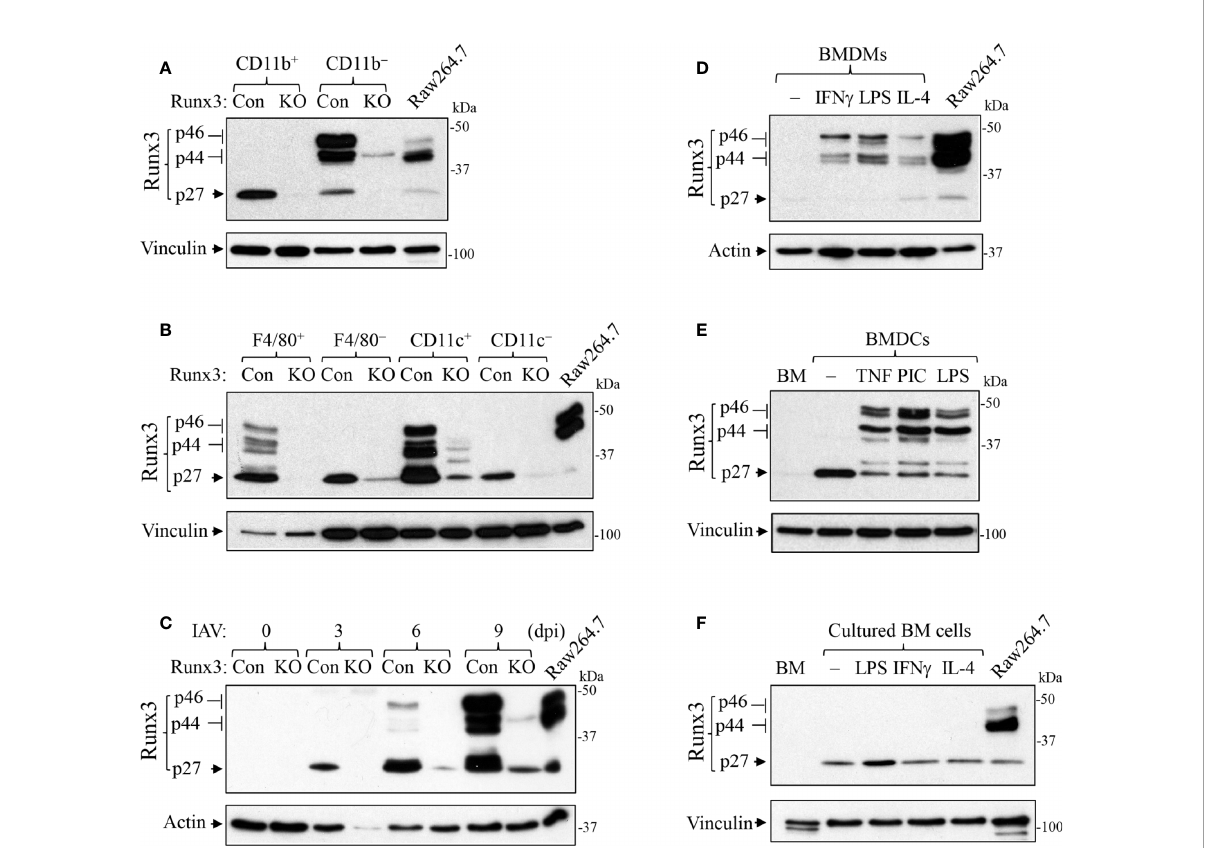
FIGURE 9 Runx3 is induced in activated macrophages and DCs. (A, B) Runx3 expression in the isolated lung innate immune cells from IAV-infected mouse lungs on day 5 pi. Equal amounts of cell lysates except that of F4/80 + cells were subjected to Western blotting with Runx3 antibody. (C) Runx3 is gradually induced in BALF cells from control mice during IAV infection. Control (Con) and Runx3 KO mice were infected with 1 LD 50 of H1N1 PR8 strain, and BALF cells were collected at different days post infection (dpi). Equal amounts of cell lysates were subjected to Western blotting with Runx3 antibody. (D – F) Runx3 is induced in activated macrophages and DCs. BMDMs (D) , BMDCs (E) , and cultured bone marrow (BM) cells (F) were treated without ( − ) or with IFN g (25 ng/ml), LPS (100 ng/ml), IL-4 (10 ng/ml), TNF a (10 ng/ml), or poly(I:C) (PIC, 1 m g/ml) for 24 h. Equal amounts of cell lysates were subjected to Western blotting with indicated antibodies. BM, freshly isolated bone marrow. Raw264.7, mouse macrophage cell line. Results are representative of the fi ndings of three independent